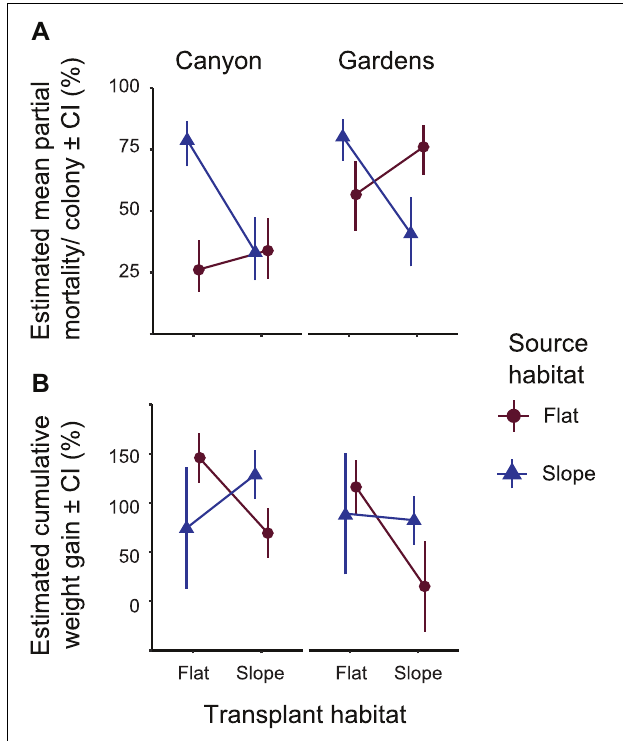
FIGURE 1 | Estimated means of (A) percent partial colony mortality and (B) percent cumulative weight gain per colony after 18 months in the field (August 2013). Positive numbers designate weight gain, negative numbers designate weight loss. Error bars on both (A,B) indicate range of possible means with 95% confidence. Significance tables, Supplementary Table 4 accompanies (A) and Supplementary Table 6 accompanies (B)